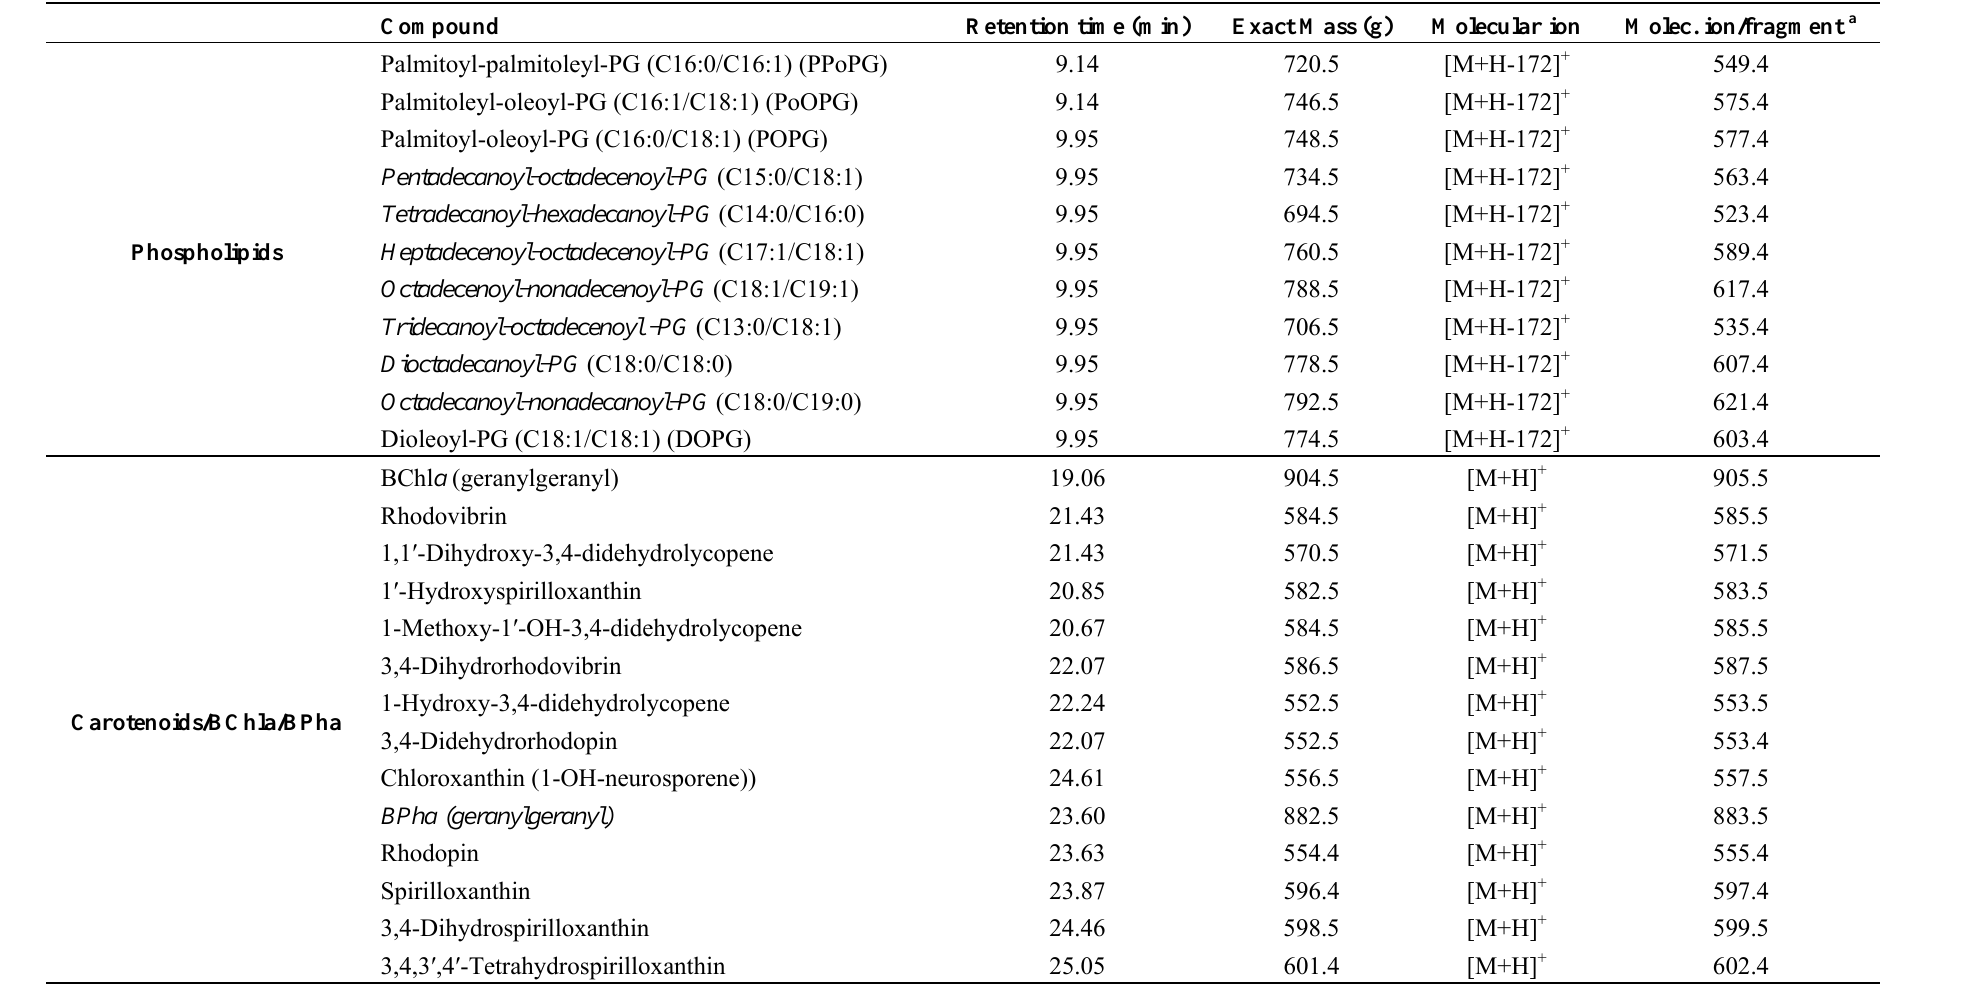
Table 1. List of identified compounds in R. rubrum . Compound Exact Mass (g) Molecular ion Molec. ion/fragment